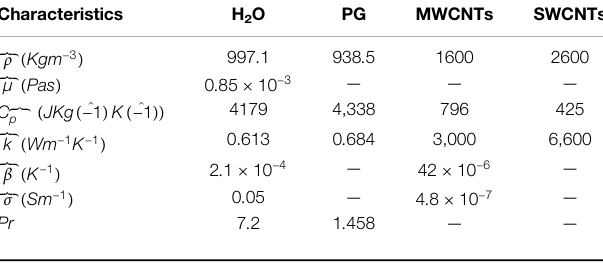
TABLE 2 | Thermophysical values of MWCNTs and PG. Characteristics